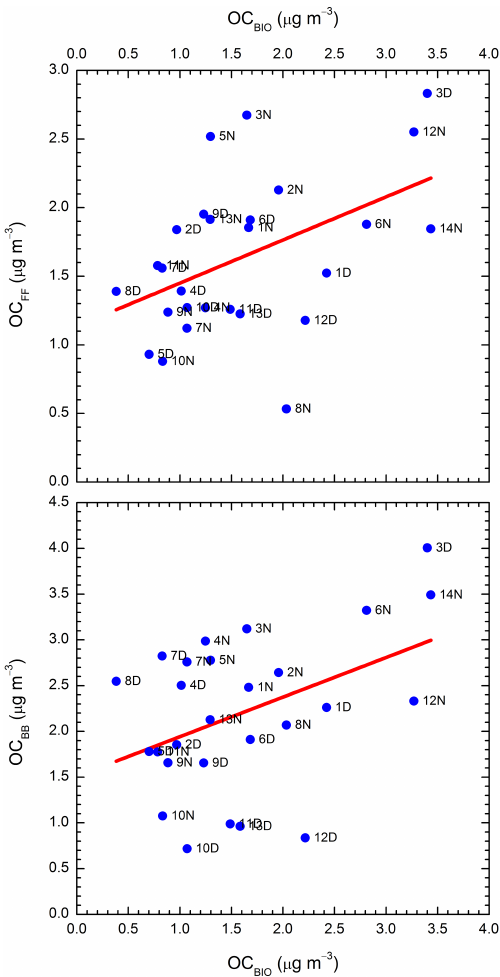
Figure 5. Scatter plots between apportioned atmospheric concen- trations of EC FF and EC BB , and of OC FF and OC BB for the PM 2 . 5 size fraction in central Budapest. The red lines represent a linear fit to the data. The order number of the samples together with daylight time (D) or night (N) periods is indicated by labels next to the data points.